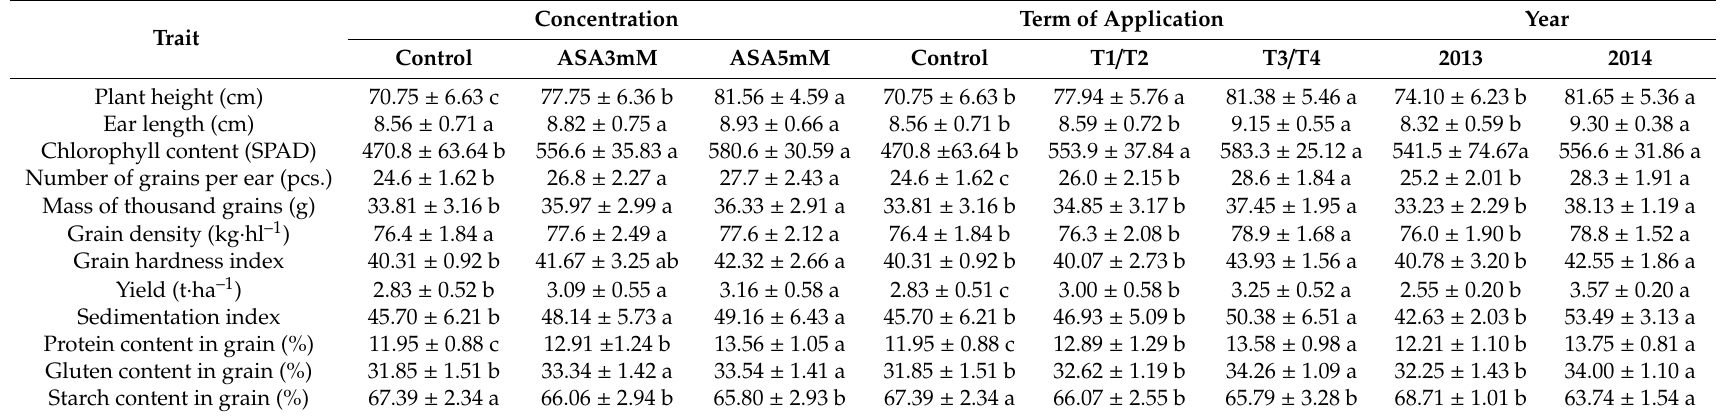
Table 3. Influence of acetylsalicylic acid on morphological traits, chlorophyll content in leaves and yield parameters of